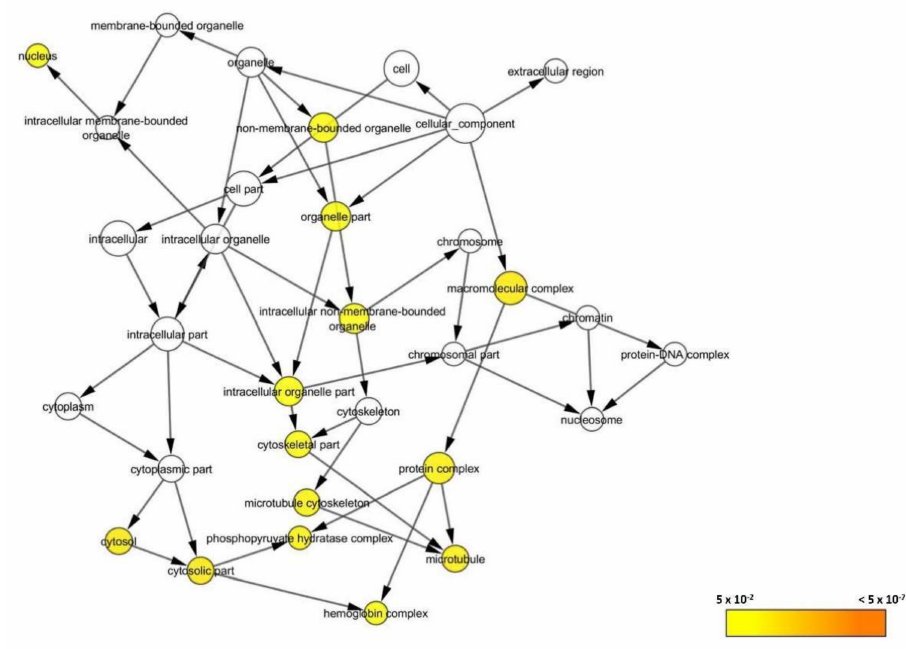
Figure 9. BiNGO result for cellular component as visualized in Cytoscape (Organism: Danio rerio ). Colored nodes are significantly overrepresented. White nodes are not significantly overrepresented; they are included to show the colored nodes in the context of the GO hierarchy. Color key on the bottom right indicates the significance level of